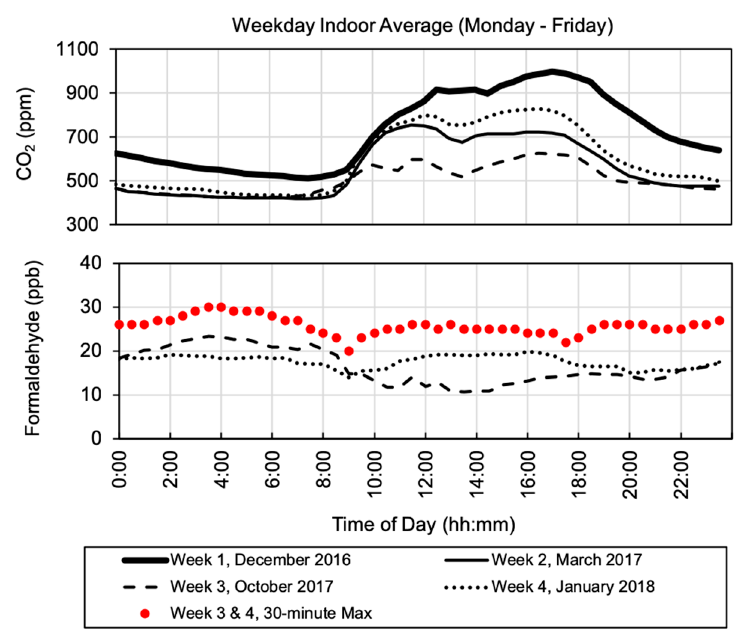
Figure 3. Weekday average indoor CO 2 and HCHO by time of day monitored in the northeast corner of the fourth-floor open office area. Formaldehyde reported using GrayWolf FM-801.